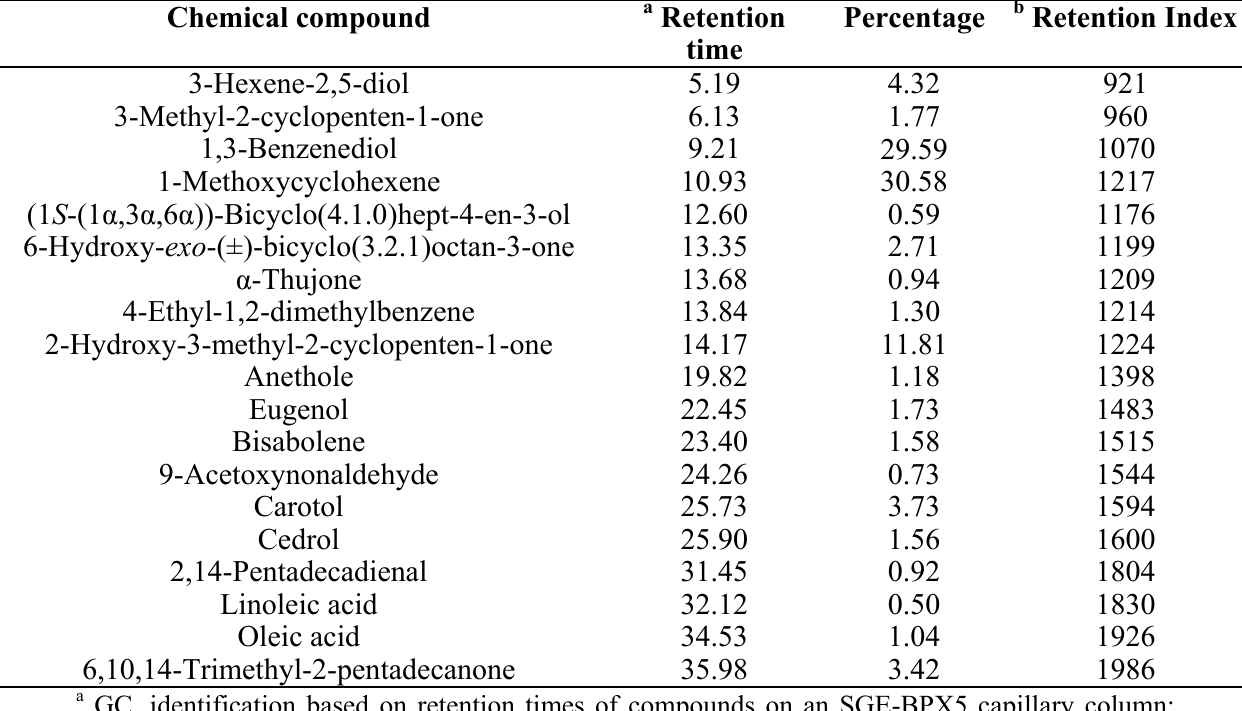
Table 1. Chemical composition of F. vulgare (fraction 7).